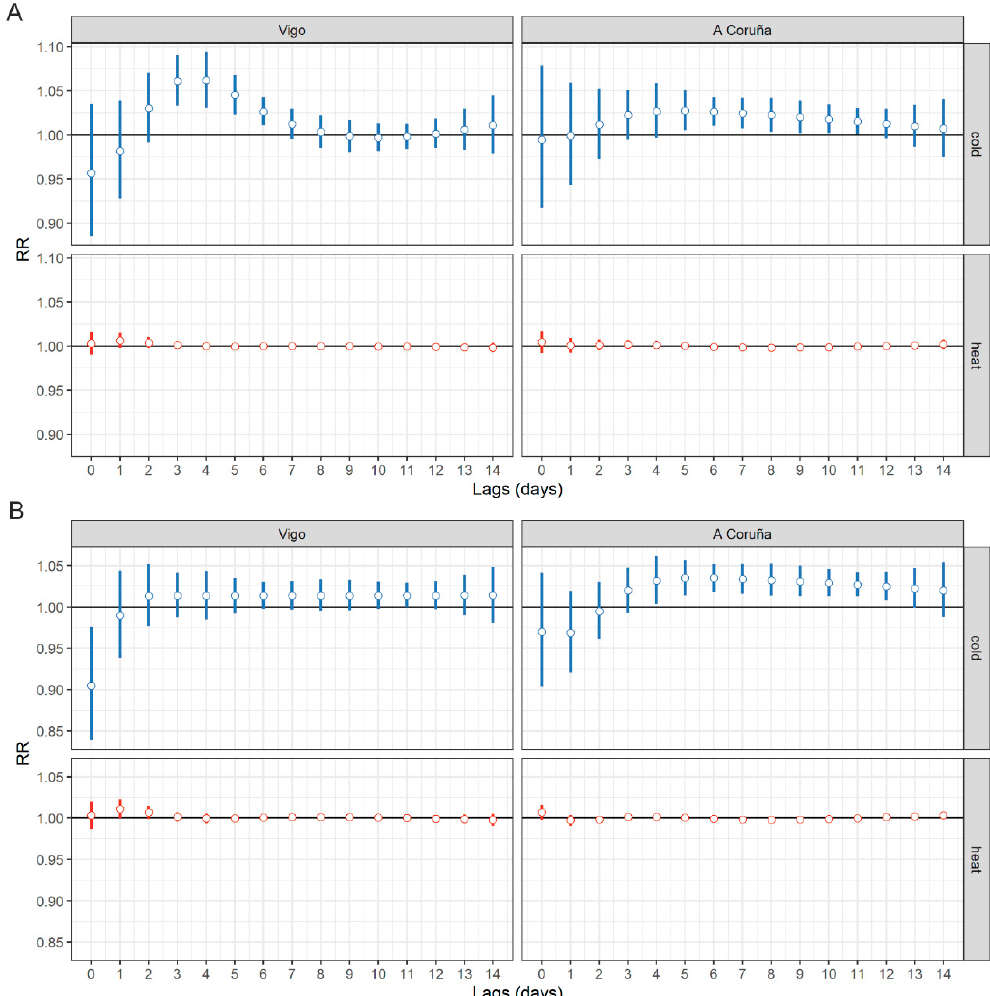
Figure 2. Structure of lags of overall cumulative heat-and cold-related effects of maximum ( A ) and minimum temperature ( B ) on emergency medical calls in the cities of Vigo and A Coruña.